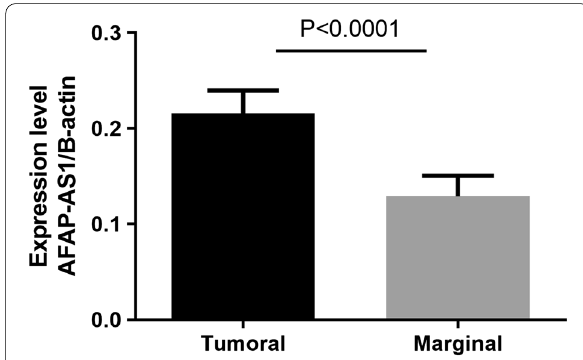
Fig. 1 The expression level of the lnc- AFAP1-AS1 between lung tumor and adjacent non-tumor tissues